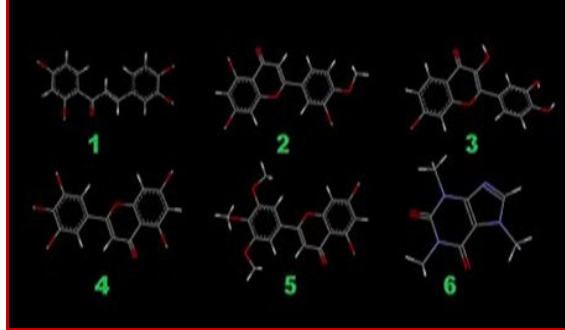
Figure 2: The optimized ligand molecules (1 Butein, 2 Dios- metin, 3 Fisetin, 4 Tricetin, 5 Tricin, and 6 Caffeine)